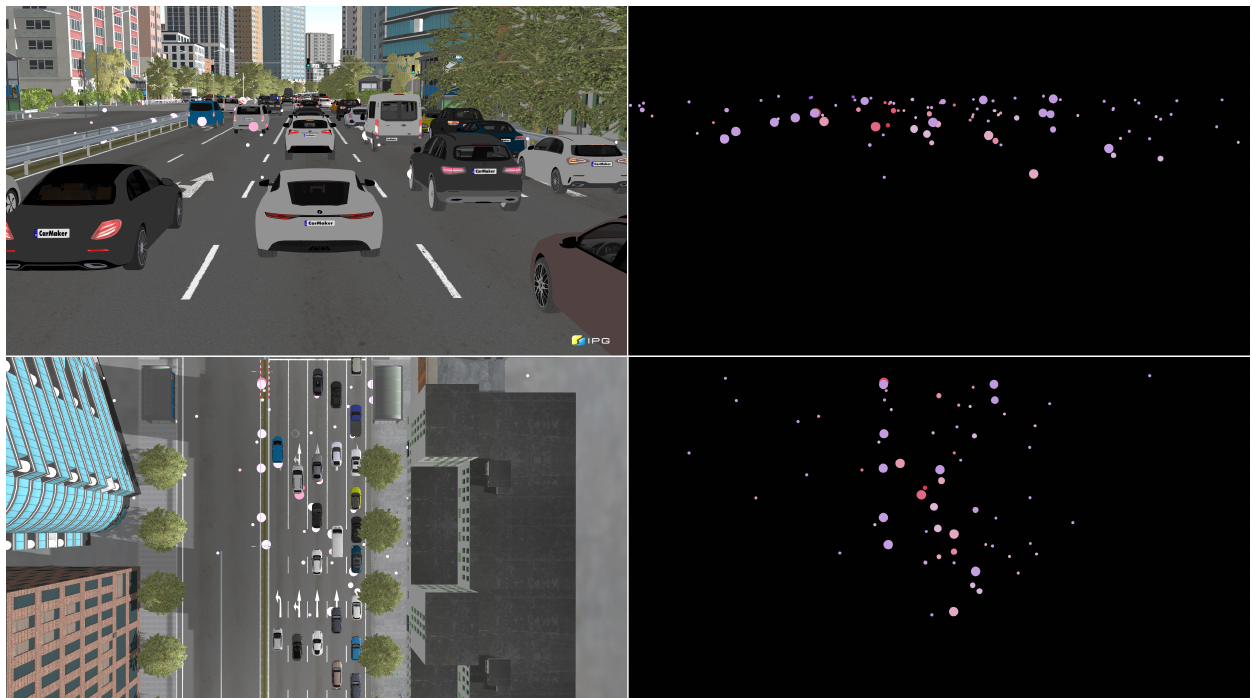
Figure 4. IPG Movie 3D environment with radar model